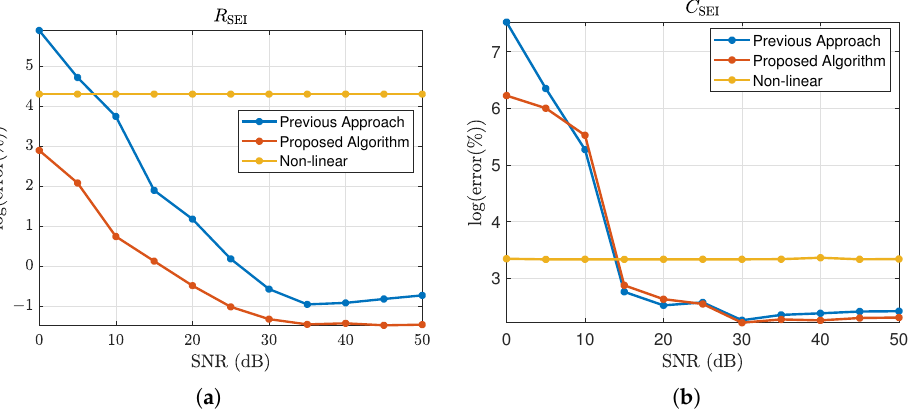
Figure 9. Parameter estimation of the SEI Arc. Blue line shows the % error in parameters estimation using previous approach. % error in parameters estimation using the proposed approach and non-linear approach is shown in red and yellow. ( a ) Solid electrolyte interface (SEI) resistance. ( b ) SEI capacitance.